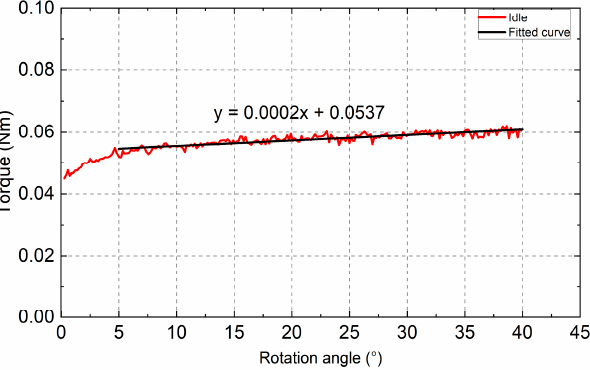
Figure 5. Fitting result of the selected resistance curve with the fitting parameters shown.